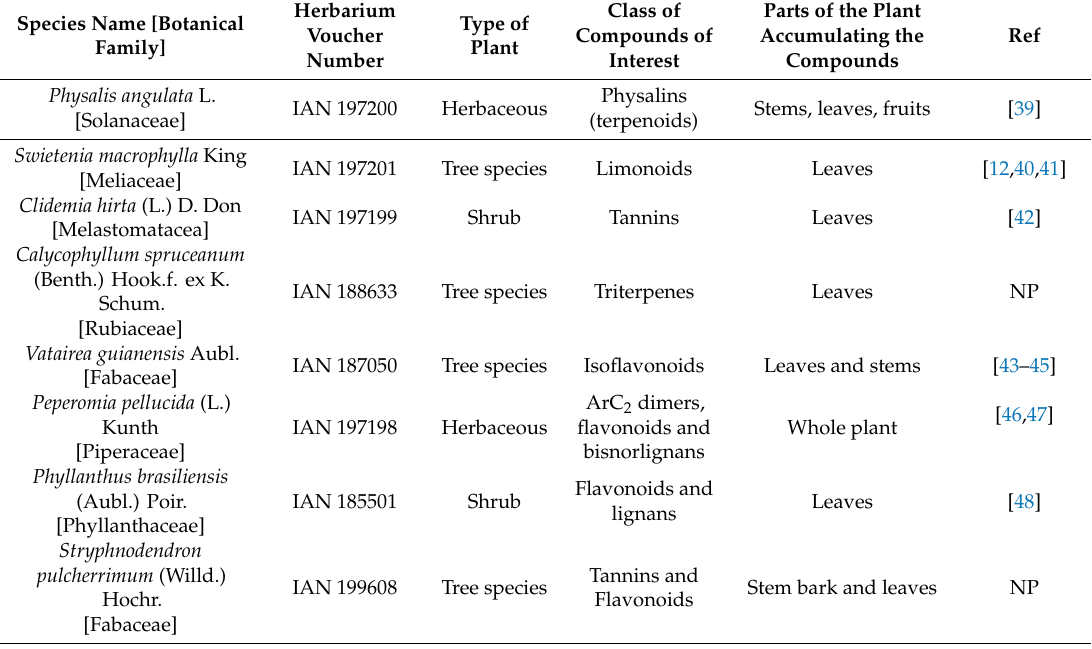
Table 1. List of selected